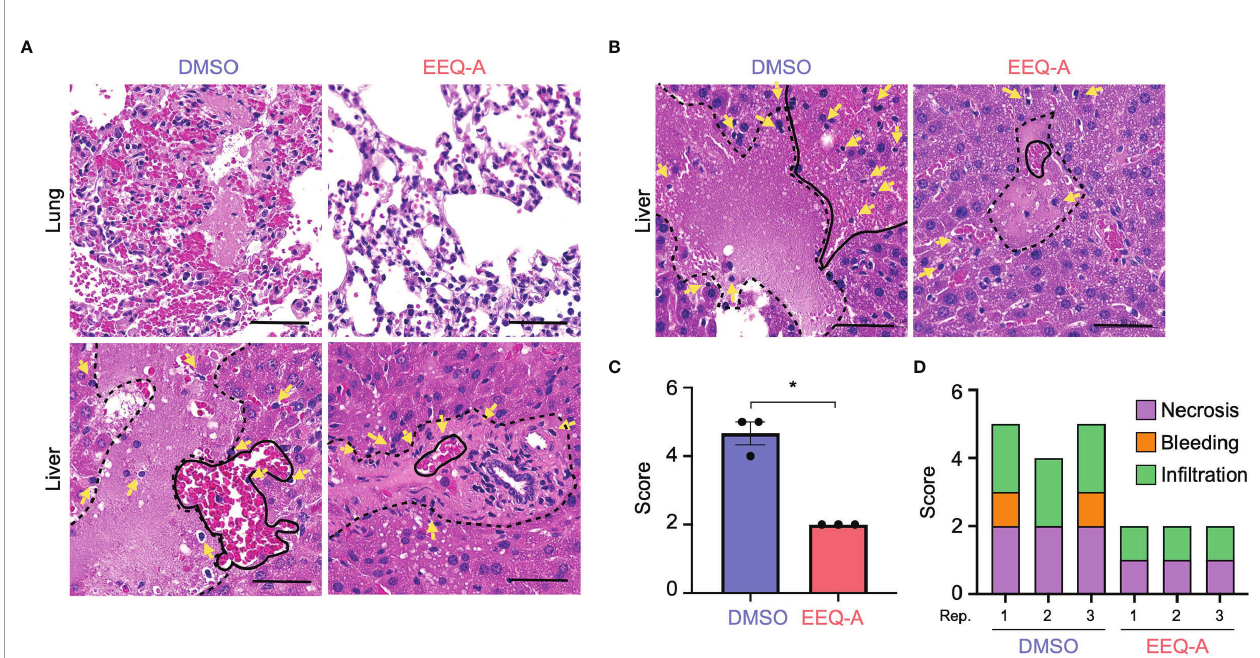
FIGURE 2 | (A) Lung and liver of mice subjected to the prevention protocol at 8 hours after LPS administration. Yellow arrows show in fi ltrating cells. The area surrounded by the dotted line is necrosis. The area surrounded by the solid line is bleeding. (B) The liver of mice subjected to the prevention protocol at 24 hours after LPS administration. Yellow arrows show in fi ltrating cells. The area surrounded by the dotted line is necrosis. The area surrounded by the solid line is bleeding. (C) The total in fl ammatory score of the liver in mice subjected to the prevention protocol at 24 hours after LPS administration (n = 3). (D) The categories of the liver in fl ammatory score (n = 3). *0.0001 to 0.05. One image was taken per organ of each animal. All bars on the images are 50 m